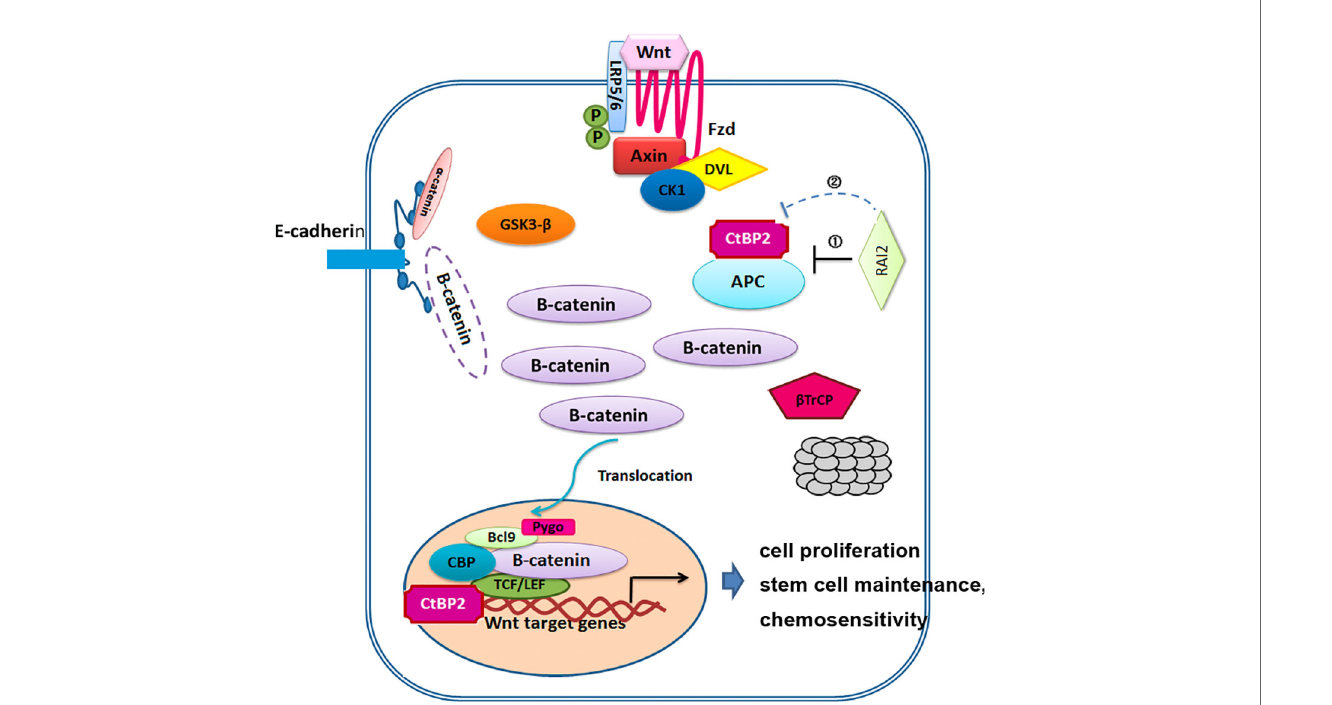
FIGURE 6 | Mechanisms model for the regulation of RAI2 in Wnt/ b -catenin signaling. ① RAI2 inhibits the interaction of CtBP2 and APC. ② RAI2 suppresses the expression of